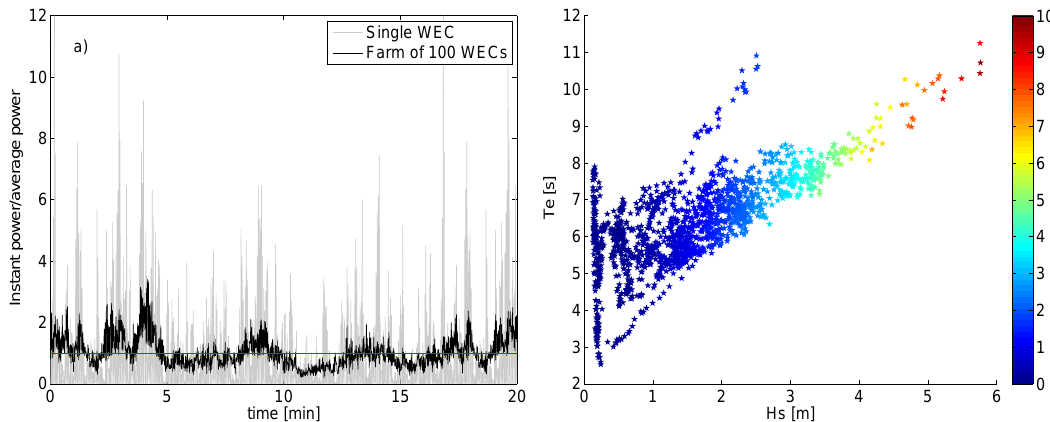
Figure 6. ( a ) Ratio between instantaneous power P tot ( t ) and time-averaged power of a single WEC (gray) and the farm of 100 WECs (black) with the configuration shown in Figure 3; ( b ) The total absorbed power (MW) for the same farm with 100 WECs, as a function of the energy period and significant wave height. All waves measured at the Lysekil test site during January 2015 have been used, separated into sea states of 30 min